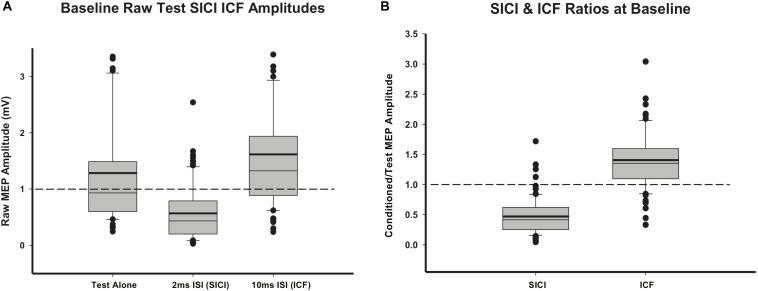
Baseline TMS data. (A) Baseline raw MEP values for test-pulse MEPs and paired-pulse (SICI and ICF) MEPs. (B) SICI and ICF ratios at baseline, calculated as raw SICI or ICF MEPs divided by raw test MEPs. Thick lines indicate mean value.